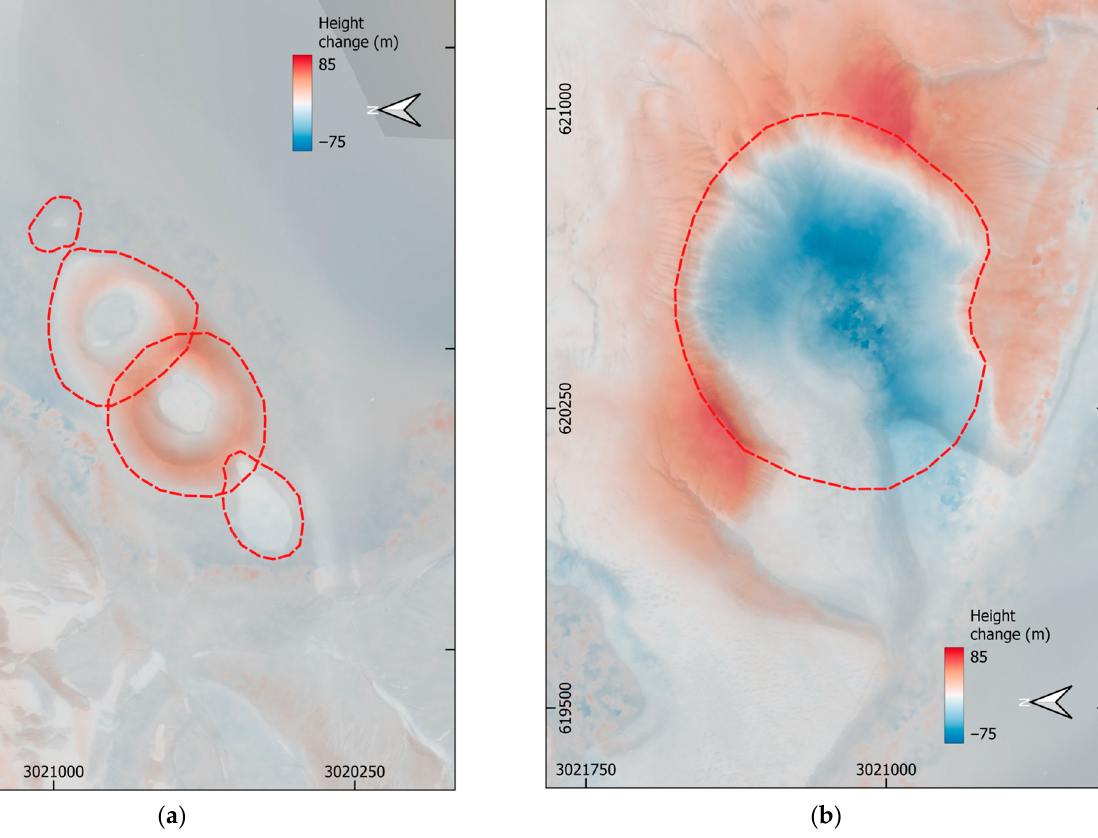
Figure 9. The composition of the orthographic mosaic of 1968 in black and white, overlapped with 30% transparency to the height differences between the 1956 and 1968 digital elevation models in colour from WGS84–UTM20S, and red dashed lines delimiting the main volcanic structures. Well- developed scoria cones and craters in Telefon Bay ( a ). The crater formed on land with a depth of about 151 m and a diameter of about 600 m ( b ).